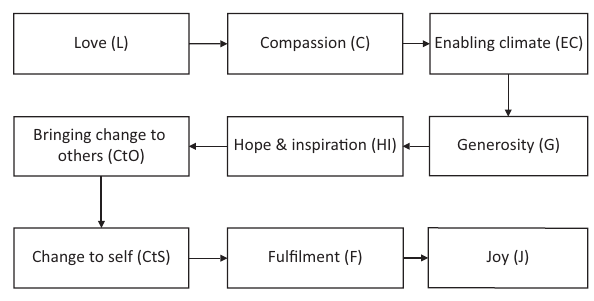
FIGURE 1: Uncluttered linear systems influence